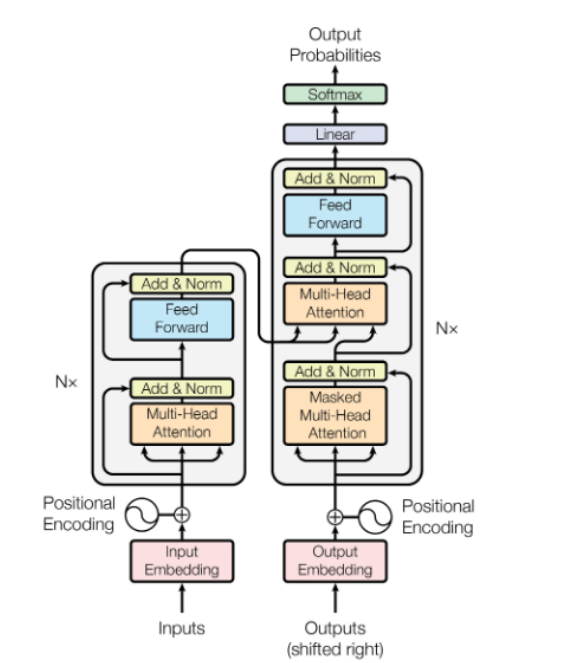
Figure 4. Transformer block architecture [24]. The left part is the encoder and the right part is the decoder.